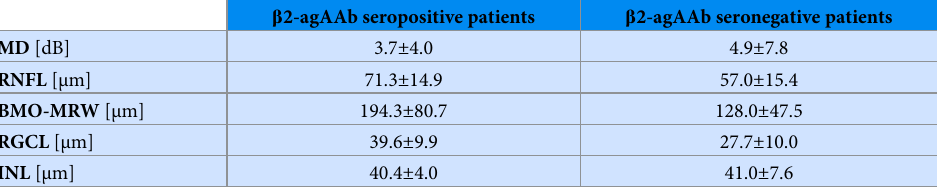
Table 2. Perimetric and morphometric data considering β 2-agAAb seropositivity: Mean defect (MD), retinal nerve fiber (RNFL), Bruchs’ membrane opening—minimum rim width (BMO-MRW), retinal ganglion cell (RGCL), inner nuclear layer